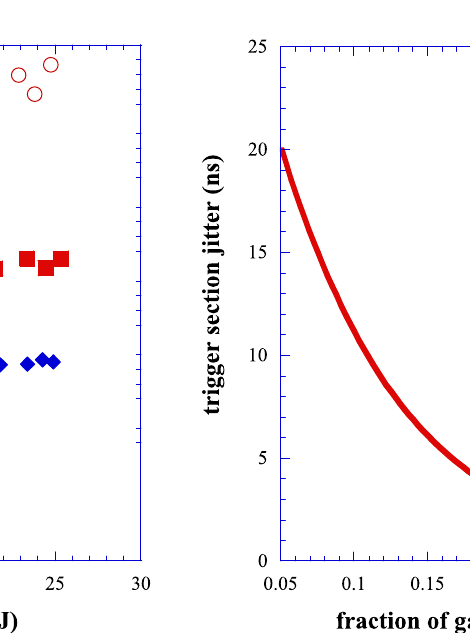
FIG. 16. (Color) Trigger section jitter as a function of the fraction of the trigger gap shorted by the visible laser